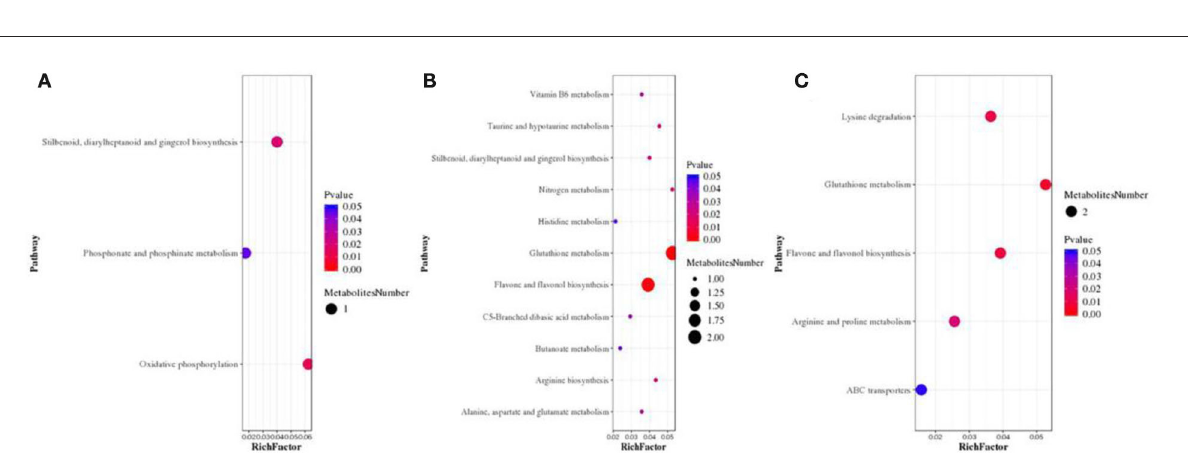
FIGURE7 Screening for bubble charts of metabolic pathways involved in E + barley and E– barley under salt stress conditions. Metabolic pathway enrichment analysis bubble chart. Metabolic pathway enrichment analysis of differential metabolites in barley samples for LC-MS data (A–C) . The x -axis Rich factor is the number of differential metabolites annotated in this pathway divided by all identified metabolites annotated in this pathway. The higher the value, the higher the ratio of differential metabolites annotated in this pathway. The dot size represents the number of differential metabolites annotated in this pathway. The measurement data are shown in Supplementary Table